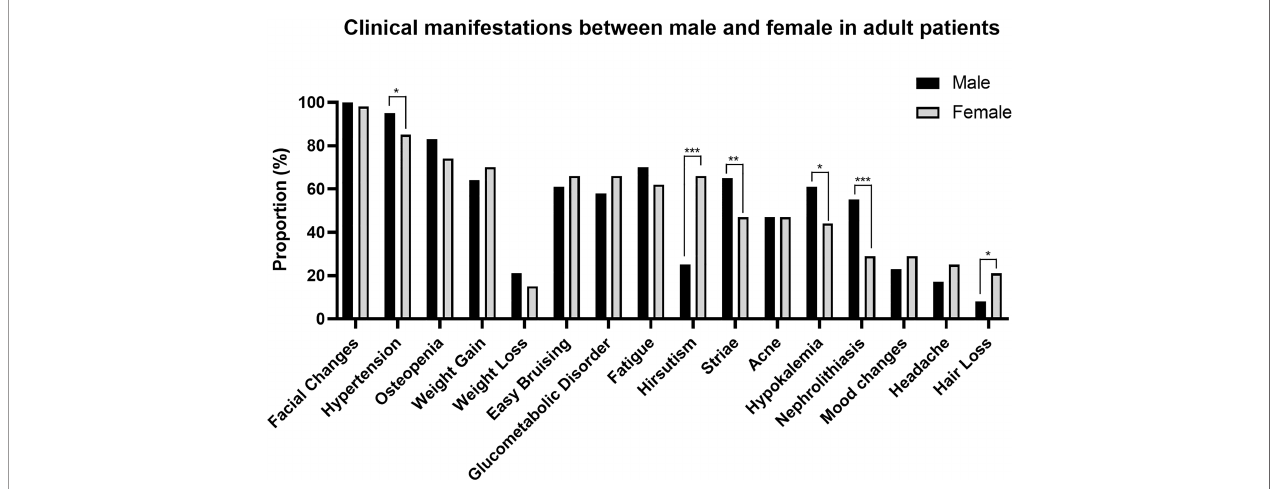
FIGURE 3 | Clinical manifestations between males and females in adult patients. * P < 0.05, ** P < 0.01, *** P <